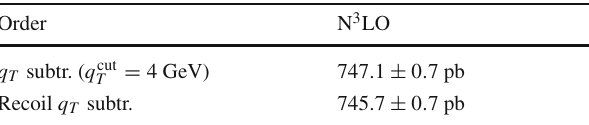
Table 2 Fiducial cross sections at the LHC ( order results at N 3 LO. The uncertainties on the values of the cross sectionsrefertothestatisticaluncertaintiesfromMonteCarlonumerical integration √ s = ) and O (α 3 ) S S